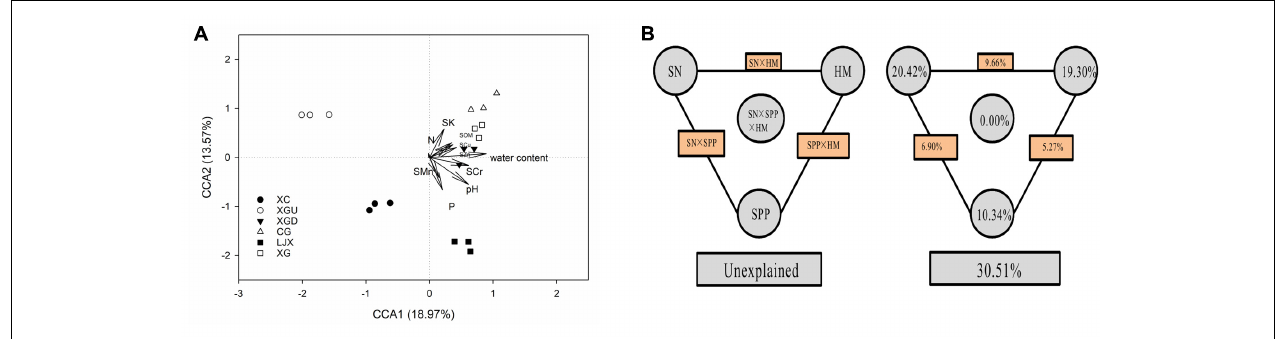
FIGURE 5 | (A) Canonical correspondence analysis (CCA) of microbial community structure and measurable variables of different samples. Arrows indicate the direction and magnitude of measurable variables associated with microbial community structure. (B) Variation partition analysis (VPA) of the effects of heavy metals (HM: SCu, SZn, SCr, SMn), soil physical properties (SPP: pH, water content) and soil nutrient (SN: SK, N, P, and SOM) on microbial community structure. The edge represents the variation explained by each factor alone. The rectangles between each set of factors represent the interactions of the two factors, and the oval in the middle represents the interaction of all three